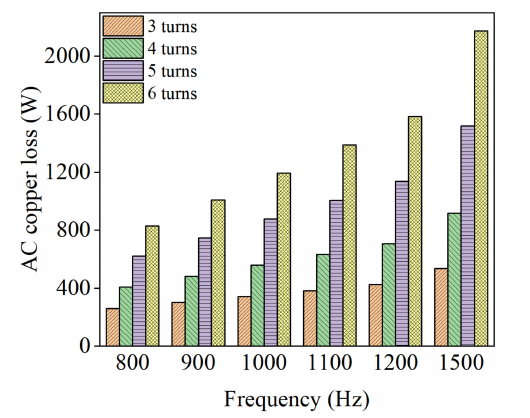
Figure 17. AC copper loss with conductor turns at different frequencies.